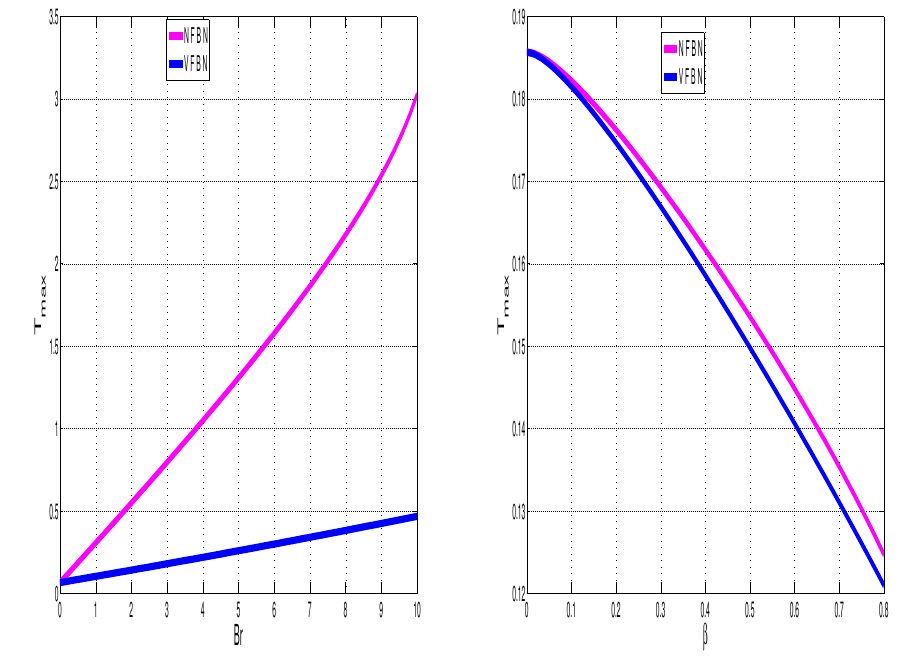
Figure 17. Comparative dependence of nanofluid temperature on Br ( left ) and β ( right ) . We conclude by demonstrating the expected increase of both the VFBN temperature and thermal conductivity with increasing activation energy parameter, α , see Figure 18. As would be logically expected, the higher the activation energy strength, the faster the exothermic reaction processes and, hence, the higher the nanofluid thermal conductivities and obtainable temperatures, as illustrated in Figure